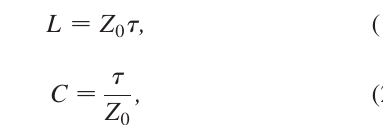
FIG. 4. (Color) Block diagram of the TL transmission-line-circuit model of the Z stack-MITL system. V Z is the impedance of the set of nine parallel water-insulated bi-plate transmission lines that drove each level, and was equal to b 0 : 48 (cid:1)